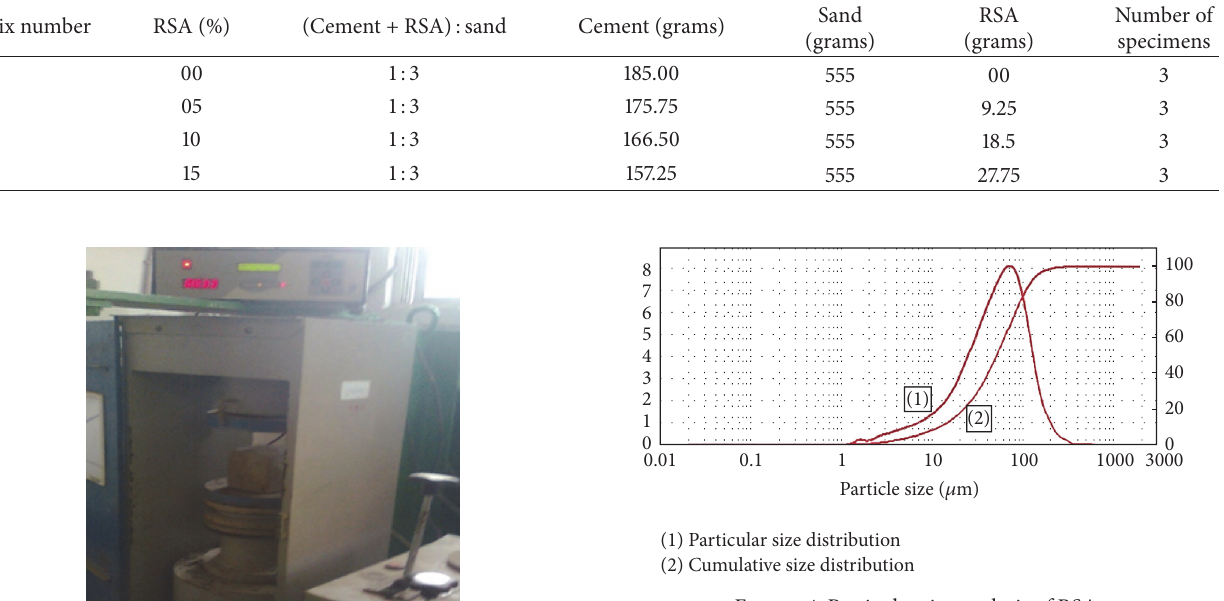
Figure 4: Particular size analysis of